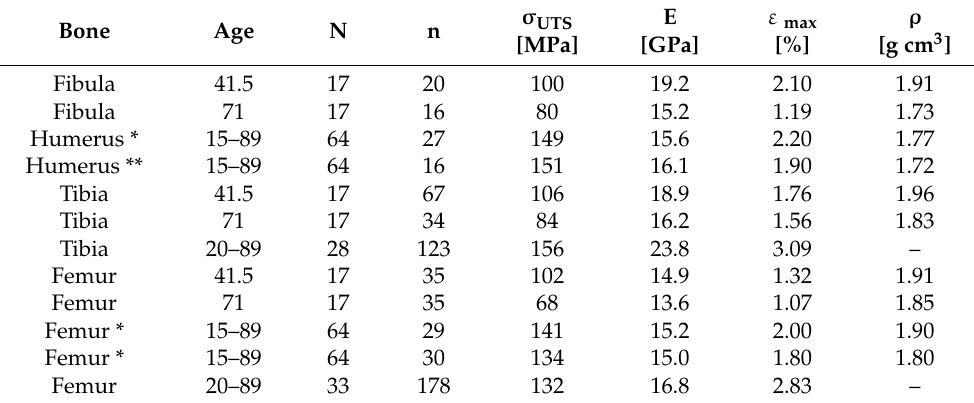
Table 2. Tensile properties of human cortical bones. Reprinted from [5], copyright (2019), with permission from John Wiley and